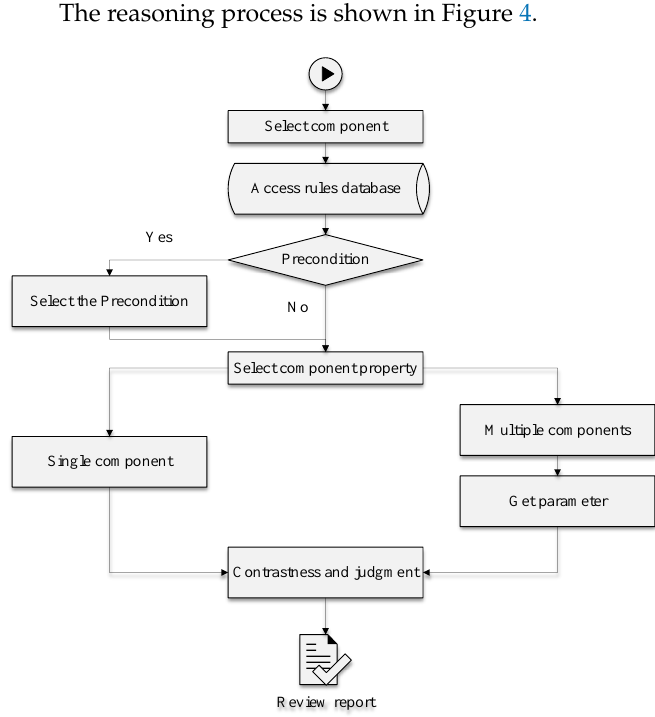
Figure 4. Reasoning